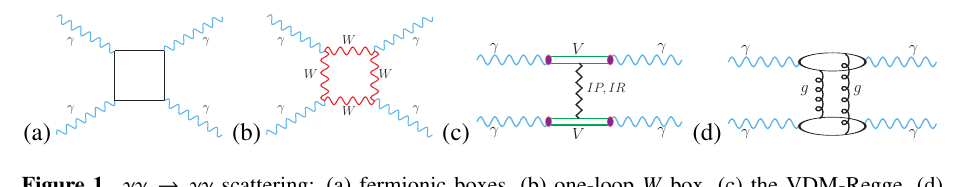
√ ˆ s is: (a) 10 GeV, (b) 50 GeV and